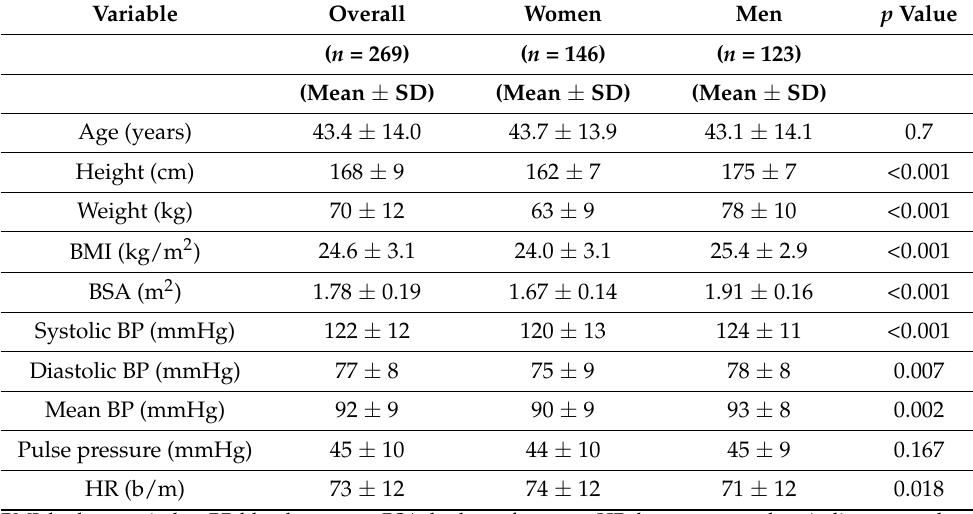
Table 1. Demographic and clinical characteristics of study